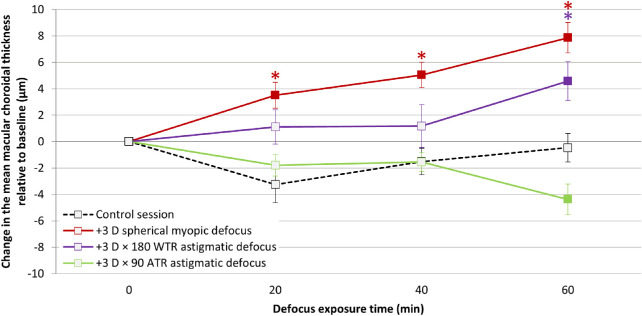
Change in the mean macular ChT of the left eye, averaged across the vertical and horizontal meridians, in response to left eye defocus. Positive and negative values denote thickening and thinning of the choroid, respectively. The filled symbols indicate a significant defocus induced change in the ChT at the corresponding time point compared with the baseline thickness (P < 0.05). The asterisks indicate a significant change in the mean macular ChT in response to defocus compared with the ChT change observed in the control session at the corresponding time point (Bonferroni adjusted P < 0.05). Error bars are the standard error of mean.